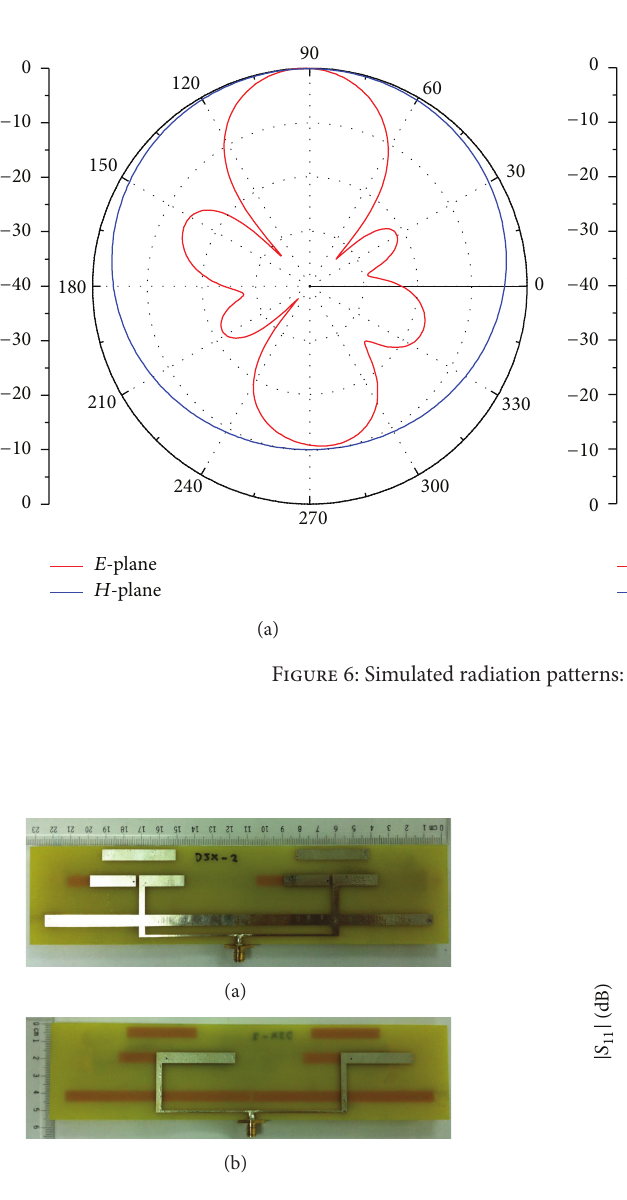
Figure 7: Antenna prototype: (a) front, (b) back.